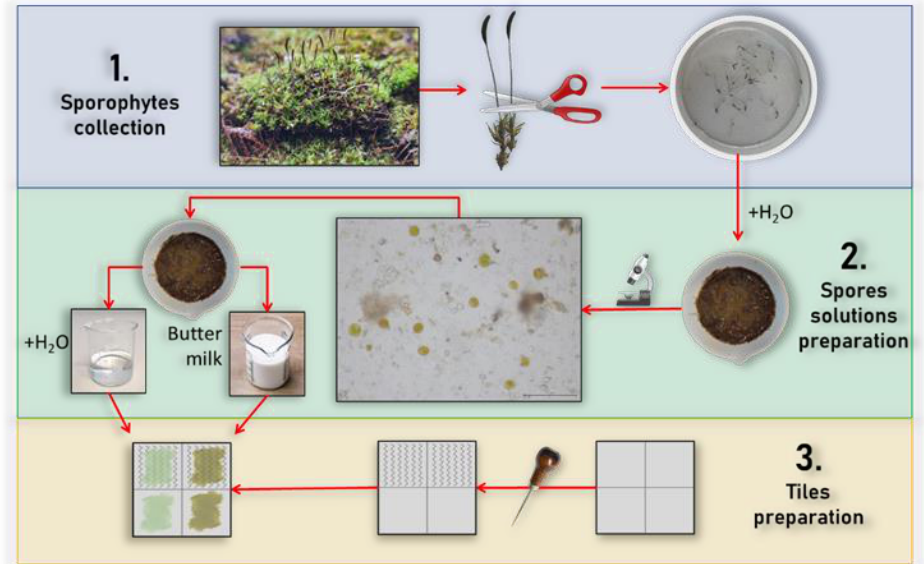
Figure 2. Flowchart showing the moss growing test procedure.